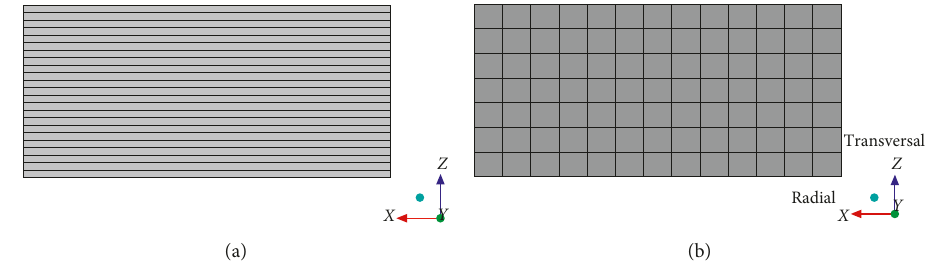
Figure 2: Principle of homogenization: (a) set of stacked disks; (b) mesh that represent the homogeneous volume of the